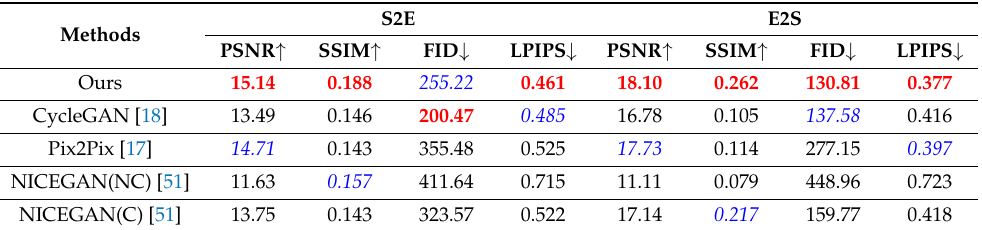
Table 3. Comparisons of IQA scores on SN6-SAROPT for S2E (SAR to EO) and E2S (EO to SAR) tasks. The best and second best results are highlighted as red bold and blue italic , respectively.